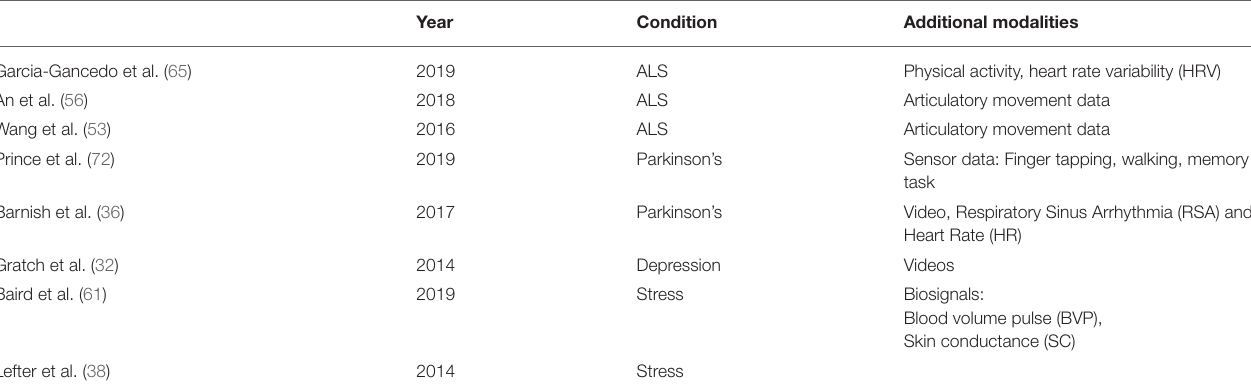
TABLE 2 | Included studies with original datasets, in which multiple modalities were recorded.